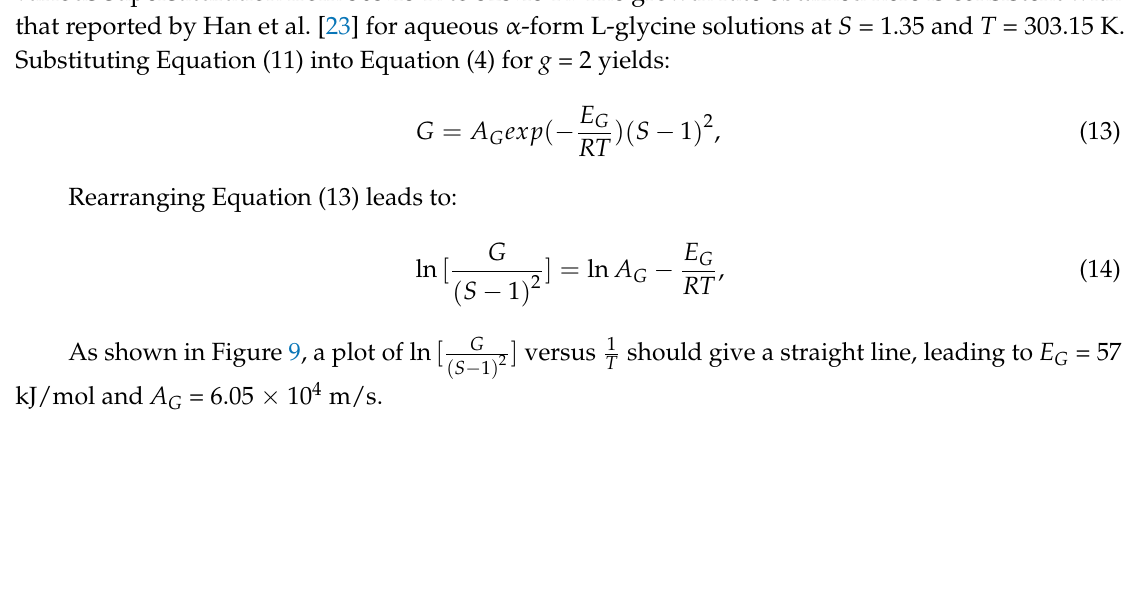
fitted to Equation fitted to Equation (12). Figure 7. The plot of T (cid:3021)